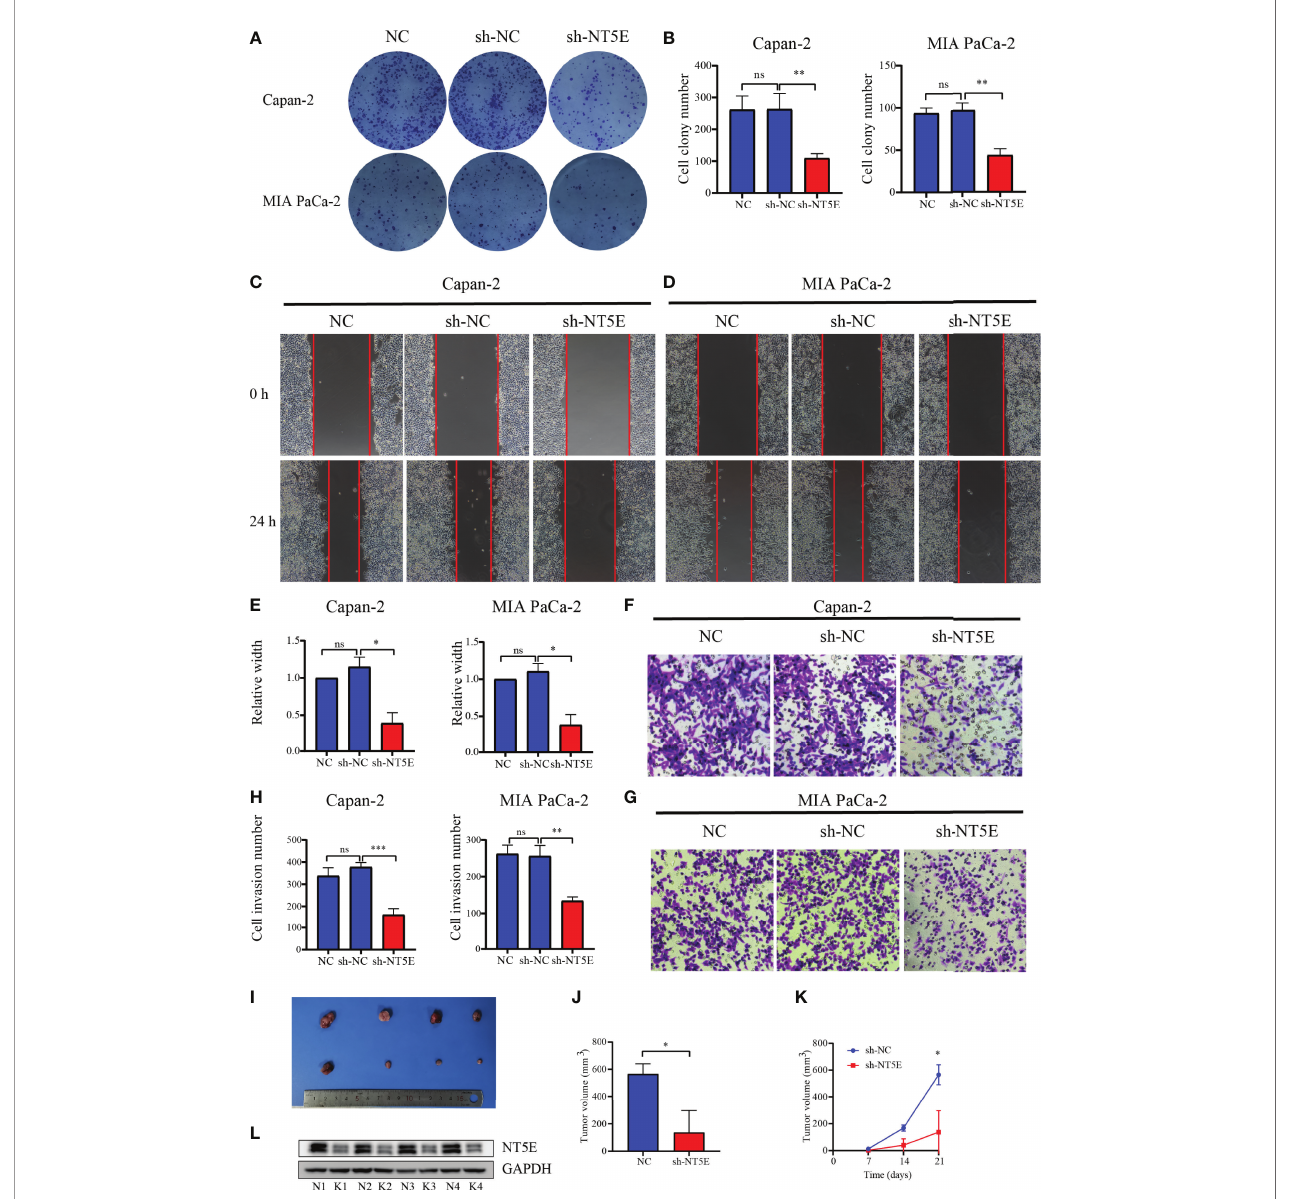
FIGURE 14 | Validation of the function of NT5E via colony formation assay, wound-healing assay, Transwell assay, and animal experiments. (A, B) Colony formation assays. (C – E) Wound-healing assays. (F – H) Transwell assays. (I – K) Animal experiments. (L) Con fi rmation of NT5E knockdown ef fi ciency in vivo by WB. N, negatively control; K, NT5E knockdown. * p < 0.05, ** p < 0.01, *** p < 0.001, ns, not signi fi